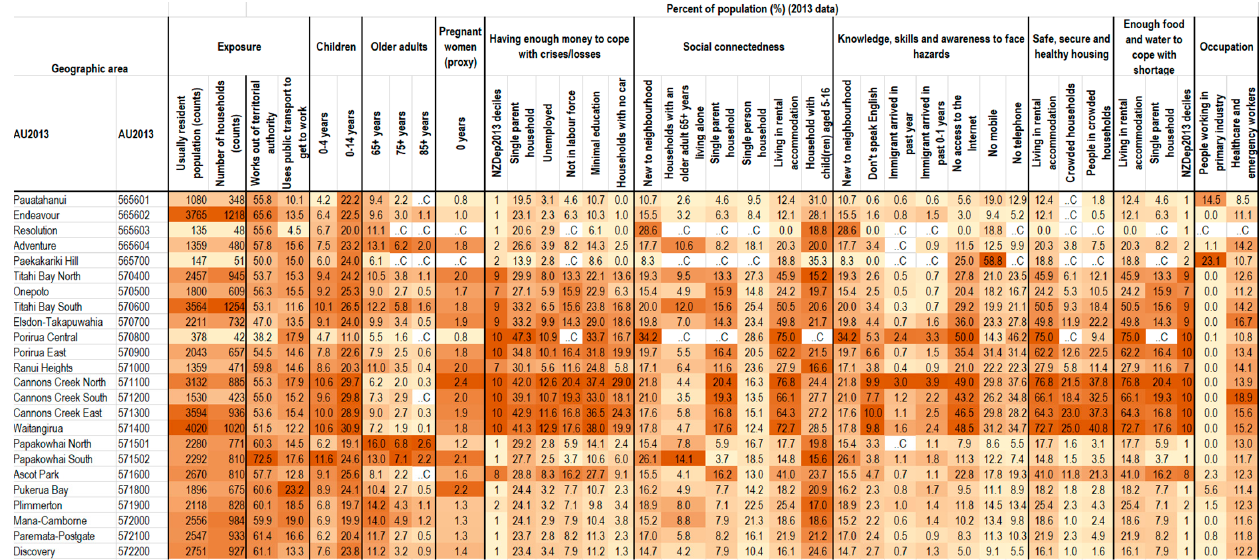
Figure 4. Social vulnerability indicators heatmap for Porirua City (2013 data by area unit (AU)) (more vulnerable areas are coloured darker) (screenshot). Note: .C denotes suppressed values due to low numbers. For the social connectedness indicator of households with child(ren) aged 5–16 years, higher values mean lower vulnerability, so lower values have been coloured darker.